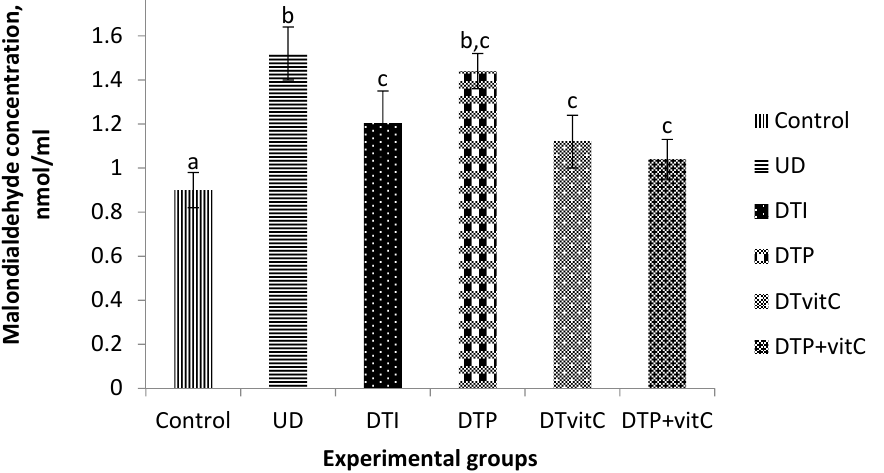
Figure 3. Effects of treatment with insulin, probiotic and vitamin C on kidney malondialdehyde concentrations of alloxan-induced diabetic rats. Abbreviations: UD, untreated diabetic; DTI, diabetic + treated with insulin; DTP, diabetic + treated with probiotic; DTVit-C, diabetic + treated with vitamin C; DTP + Vit-C, diabetic + treated with probiotic and vitamin C. The values are expressed as mean ± S.E. ( n = 5). Values with different superscript letters are significantly ( p < 0.05) different.